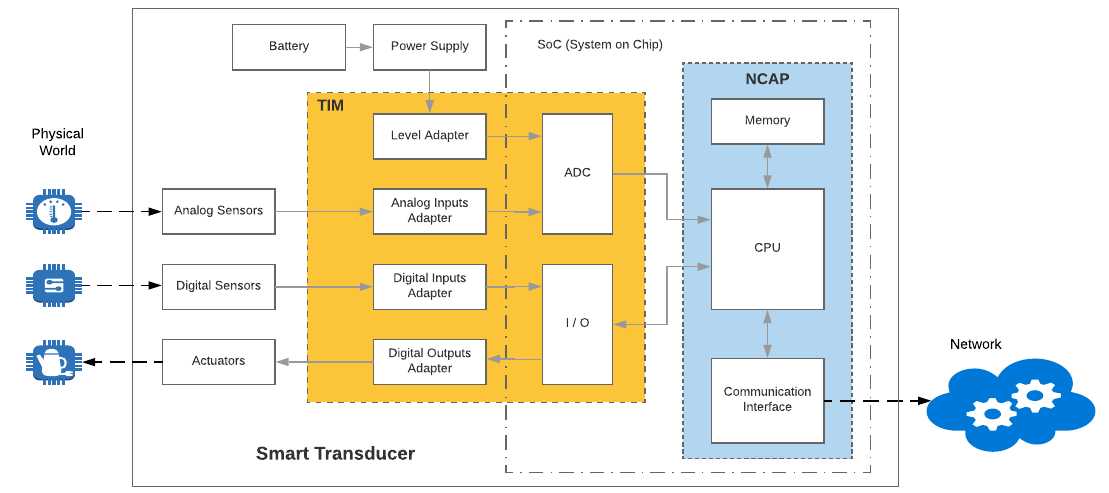
Figure 2. Smart transducer basic